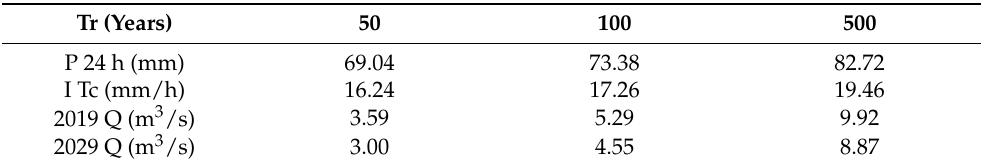
Table 3. Return periods, estimated maximum rainfall in 24 h, intensity for a storm time equal to concentration time, and flow rates for 2019 and 2029 coverages.